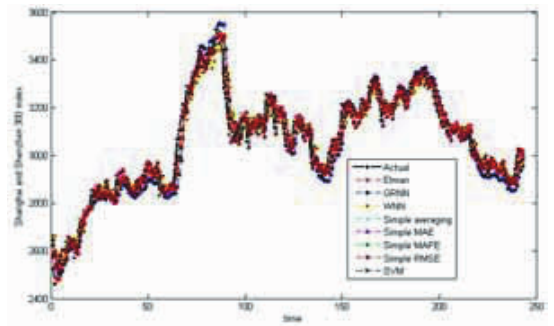
Fig. 4. The prediction of the daily stock index data of Shanghai-Shenzhen 300 index using three single base models, four linear ensemble methods, and the proposed non-linear ensemble